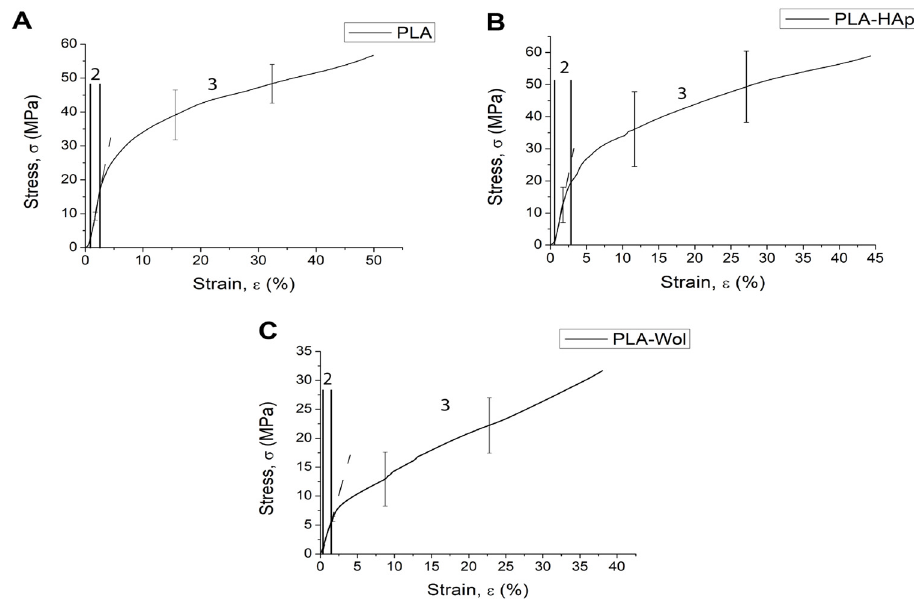
Figure 6. “Stress–strain” curve for PLA ( A ), PLA/HAp ( B ), PLA/Wol ( C ) scaffolds.